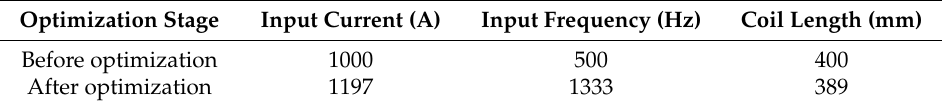
Table 4. X values before and after the